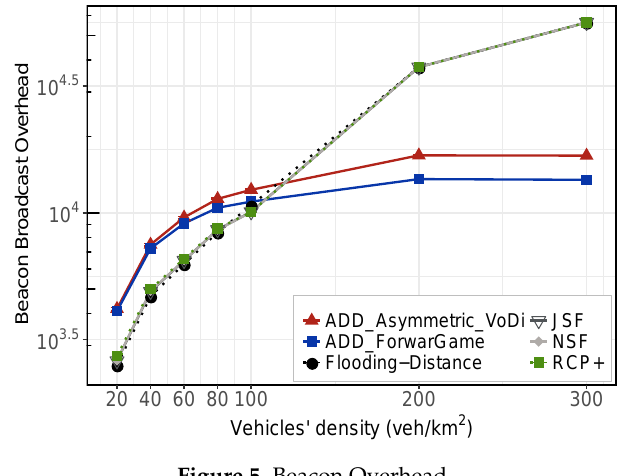
Figure 5. Beacon